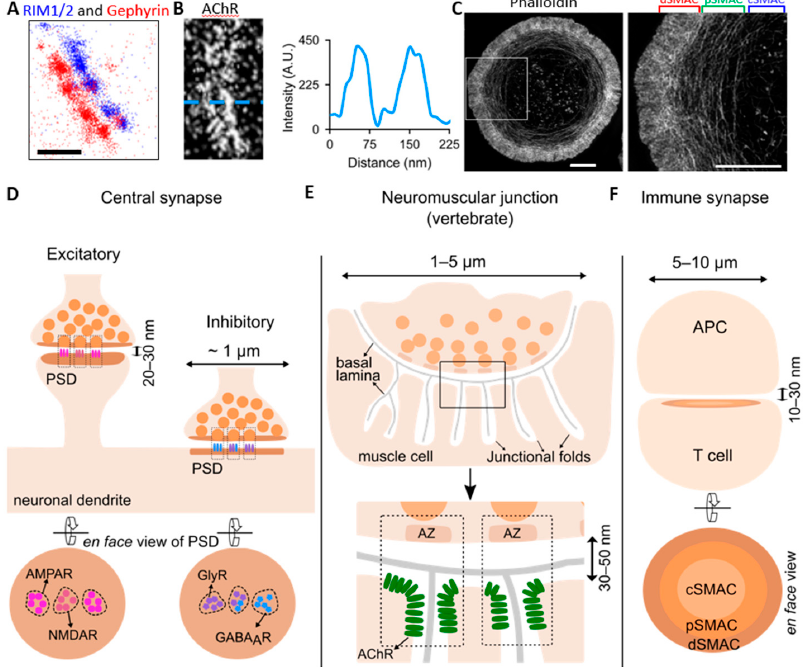
Figure 1. Synaptic structures under super-resolution microscopy. ( A ) Dual-color direct stochastic optical reconstruction microscopy (dSTORM) of pre-synaptic Rab3-interacting molecule 1/2 (RIM1/2) (in blue) and post-synaptic gephyrin (in red) at inhibitory synapses in cultured spinal cord neurons, showing the alignment of their nanodomains (modified from [18]). Scale bar: 200 nm. ( B ) dSTORM of acetylcholine receptor (AChR) strip at a neuromuscular junction (NMJ) (left) and line-scan profile (right) showing the slit in the AChR strip [19]. ( C ) 3D-structured illumination microscopy (SIM) imaging of an activated Jurkat T cell stained with phalloidin, showing the discrete actin networks [20]. Zoom-in view of the boxed region on the left is shown on the right. Scale bar: 5 µ m. ( D ) Excitatory and inhibitory synapses in the central nervous system, with a size generally below 1 µ m and synaptic cleft of 20–30 nm. Post-synaptic receptors are organized into sub-synaptic domains (SSDs) and aligned with pre-synaptic vesicle release sites, forming trans-synaptic nanocolumns (indicated by boxes with dashed lines in the upper panel). The lower panel shows the en face view of the excitatory and inhibitory post-synaptic density (PSD). The left shows the N-methyl-D-aspartate receptor (NMDAR) SSD in the center and several α -amino-3-hydroxy-5-methyl-4-isoxazolepropionic acid receptor (AMPAR) SSDs surrounding it at the excitatory PSD. The right shows the glycine receptor (GlyR) and γ -aminobutyric acid type A receptor (GABA A R) SSDs and their partial overlapping at the inhibitory PSD. ( E ) The vertebrate neuromuscular junction (NMJ), which has a diameter of 1–5 µ m, and the synaptic cleft is 30–50 nm (lower panel). The muscle cell plasma membrane forms many junctional folds, and the synaptic cleft is resided by the basal lamina. The lower panel is the zoomed-in view of the boxed region in the upper panel. The dashed boxes indicate the trans-synaptic nanocolumns consisting of the pre-synaptic active zones (AZ) and the post-synaptic AChR clusters at the junction crest shoulder. ( F ) The immune synapse (IS) formed between T cell and antigen-presenting cell (APC), with a size of 5–10 µ m and a cleft of 10–30 nm. The lower panel is the en face view of the post-synaptic compartment of the IS, depicting the central supramolecular activation cluster (cSMAC) enriched in T cell receptors (TCRs, light orange), the peripheral SMAC (pSMAC) enriched in linker for activation of T cells (LATs, orange), and the distal SMAC (dSMAC) enriched in F-actin